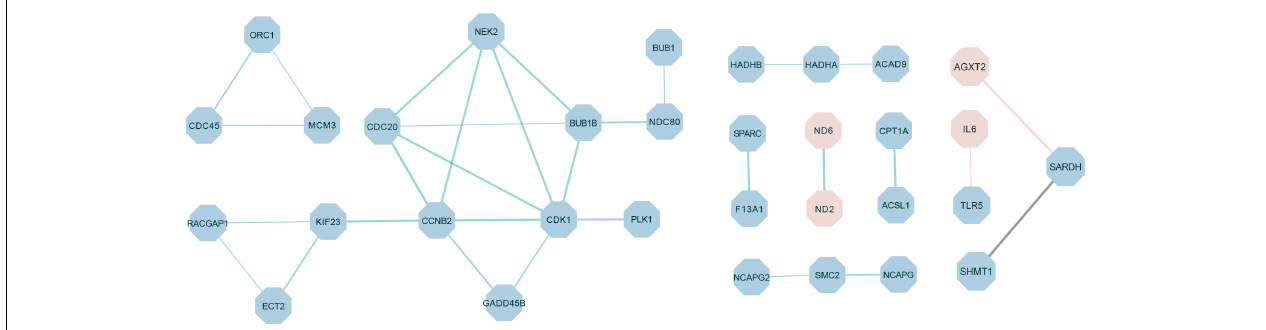
FIGURE 6 | The protein–protein interaction (PPI) network of differentially expressed proteins in different comparisons. The green connection represents W22 vs. W6 , the purple connection represents W22 vs. W14 , the red connection represents W30 vs. W6 and the black connection represents W30 vs. W14 . Red represents up-regulated genes, and blue represents down-regulated genes. The thickness of the lines indicates the level of confidence in protein interactions.